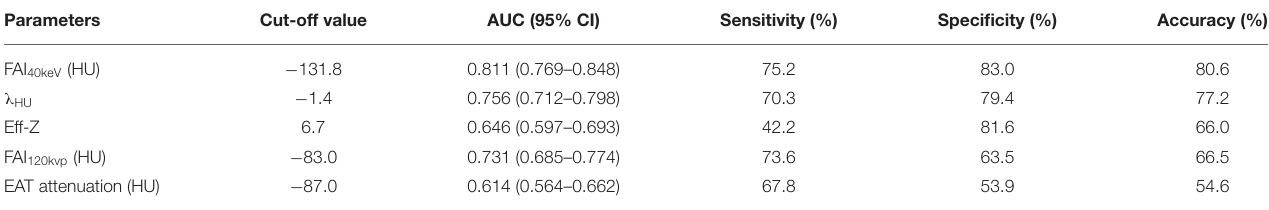
TABLE 5 | Cut-off values of PCAT indices and EAT attenuation for the detection of CAD.